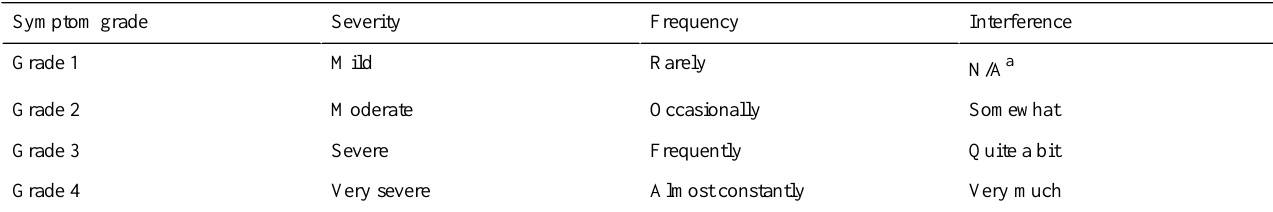
Table 2. Composite symptom grade definitions.